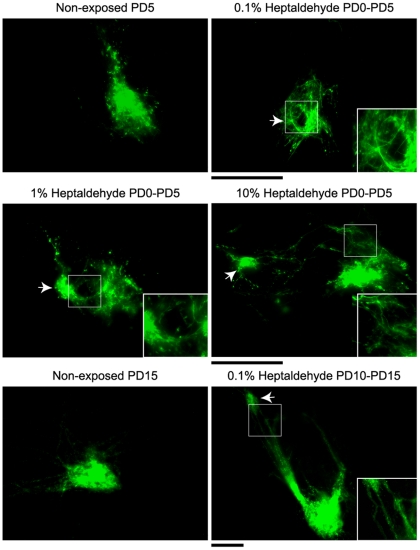
The largest glomeruli displayed primary afferent reorganization within a restricted space during chronic odorant exposure.The figure shows the expression of I7tauGFP glomeruli in non-exposed mice and mice exposed to heptaldehyde. Notice that primary afferents redistribute in variable ways between the largest and supernumerary glomeruli (arrows) in exposed mice. The effect was seen in all half bulbs analyzed (n = 10 for each condition) when mice were exposed from postnatal day (PD) 0 to PD5. In mice exposed from PD10 to PD15 the effect was seen in 8 out of 10 total half bulbs analyzed. Scale bar 100 µm; inset square is 2× magnification.